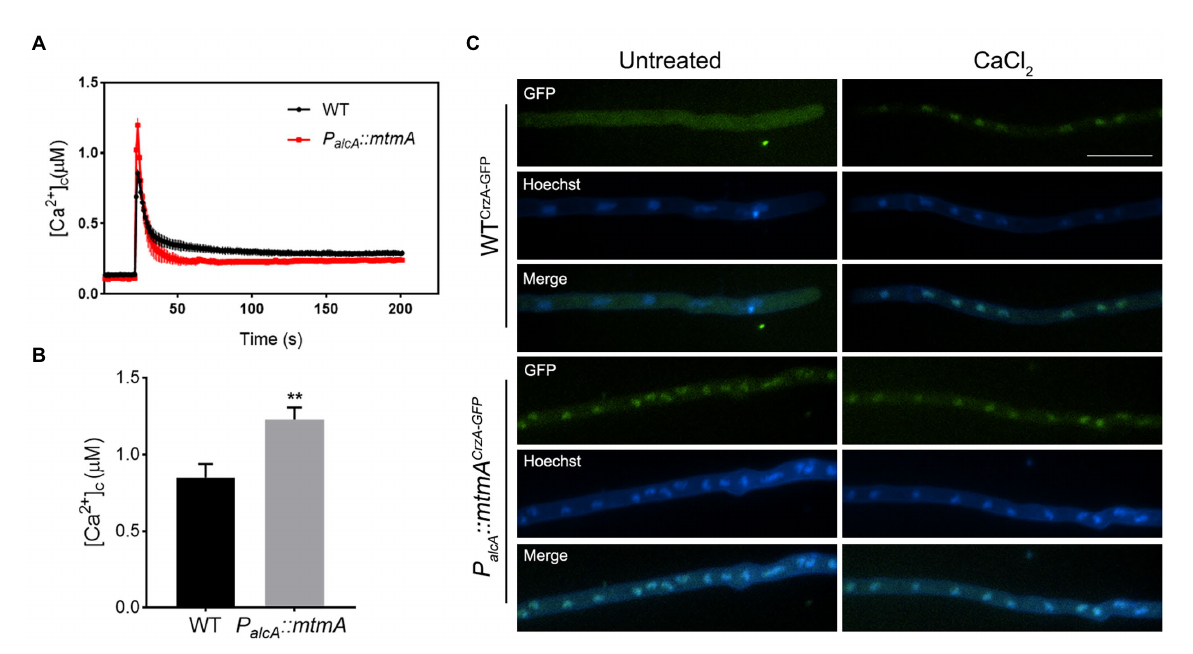
FIGURE 5 Repressed expression of MtmA led to enhanced transient cytosolic Ca 2+ levels and localization of CrzA-GFP. (A,B) The aequorin-expressing strains were stimulated with 100 mM CaCl 2 after growth in MM + glucose. The linear graphs indicated that the real-time [Ca 2+ ] c changes in response to calcium stimuli. [Ca 2+ ] c , free Ca 2+ concentration in the cytoplasm. Basal [Ca 2+ ] c was indicated by the resting level prior to extracellular calcium stimulus at the 50-s time point. [Ca 2+ ] c amplitude was indicated by the poststimulatory peak value of [Ca 2+ ] c . Data are the average from at least six experiments. Values represent the mean ± SD. **, p < 0.01. (C) Epifluorescence microscopic images demonstrating the CrzA-GFP distribution under untreated or treatment with CaCl 2 (100 mM) for 15 min in the WT and the mtmA -repressed strains. Hoechst is a nuclear localization signal dye used to visualize the nucleus. The scale bar represents 10 μ